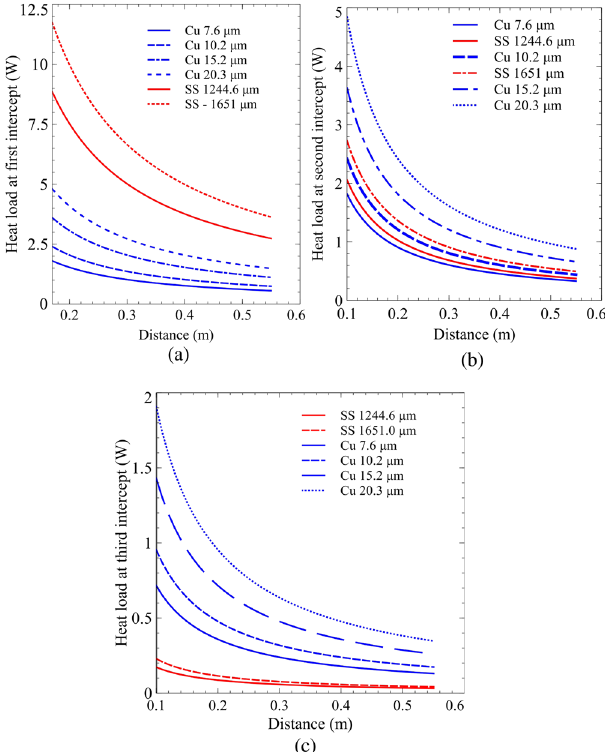
FIG. 7. Q variation with thickness of Cu, SS and stage length (a) from 300 K to 85 K (b) from 85 K to 25 K and (c) from 25 K to 6.5 K